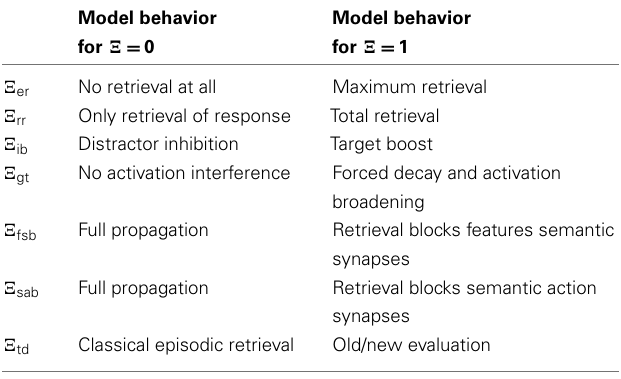
Table 3 : (cid:52) er ,episodic retrieval; (cid:52) rr ,response retrieval; (cid:52) ib ,inhibi- tion vs. boost; (cid:52) gt , global threshold; (cid:52) fsb , feature-semantic block; (cid:52) (cid:52) sab , semantic action block; td , temporal discrimination. Retrieval is controlled by adjusting the initial strength of a memory trace as it linearly determines the impact of retrieval. The Table 3 |Weights controlling the strength of the implementation of a theoretical account into the